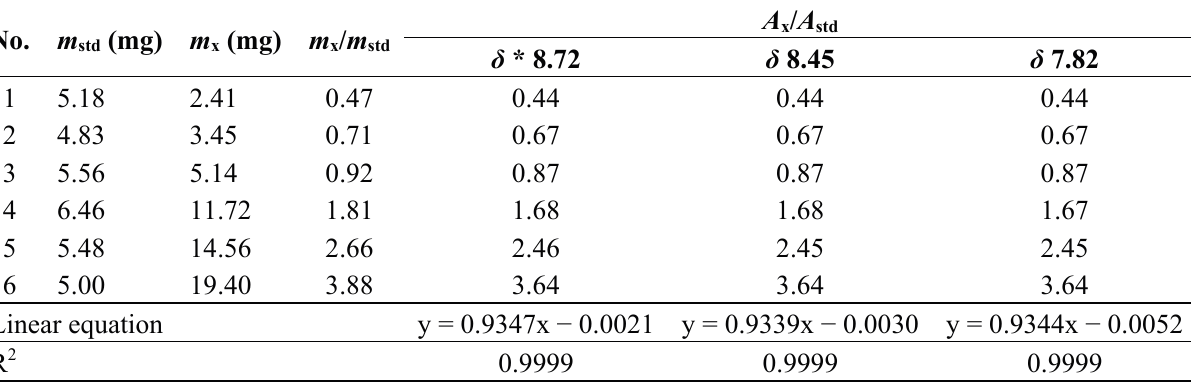
Table 1. Linearity and range of tadalafil by quantitative NMR